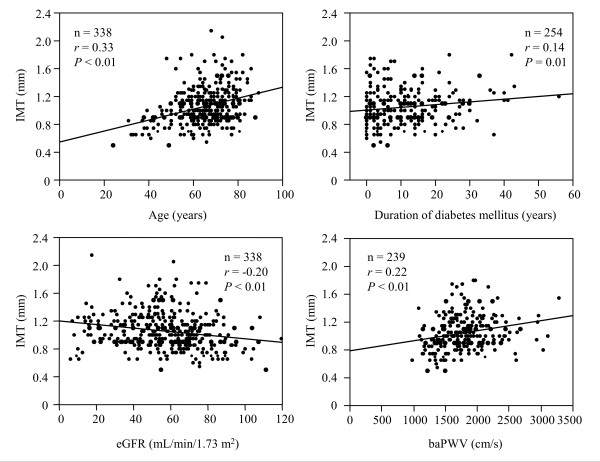
Correlation of the IMT to the clinical parameters. The IMT positively correlated with age, duration of diabetes mellitus, and baPWV and negatively correlated with eGFR. The level of the eGFR that the IMT was equivalent to 1.1 mm was 41.3 mL/min/1.73 m2 according the formula of the correlation (y = -0.0025729x + 1.2064048).